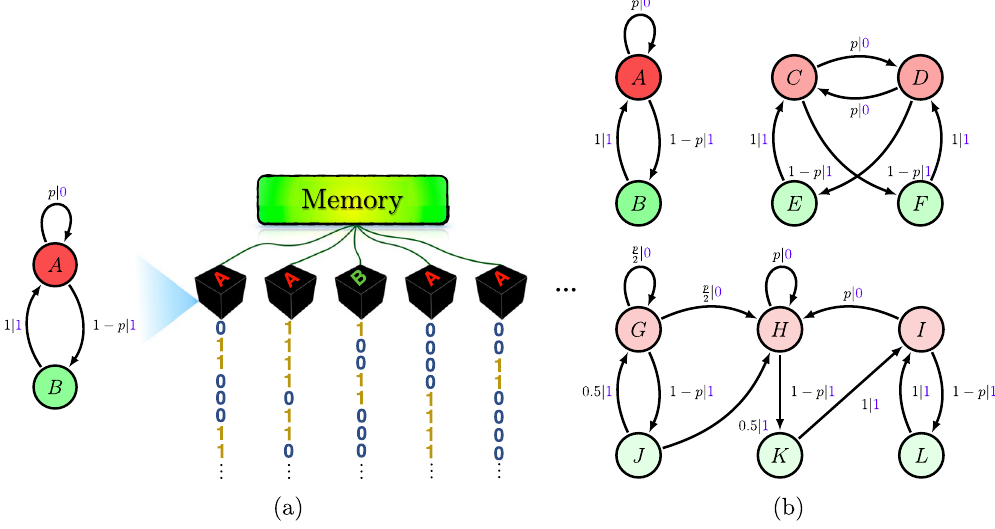
Figure 1. ( a ) Left: Even Process  -machine. Right: Schematic of simultaneous generation problem. Each black box contains an Even Process generator. They all share the same memory for tracking the individual generator states. ( b ) Alternative HMMs: Even Process generators, each with different memory costs. Top: Unifilar HMMs, since for every state and symbol there is at most one outgoing edge from that state emitting that symbol. Below: Nonunifilar HMM, since for example state G can go to different states G or H emitting symbol